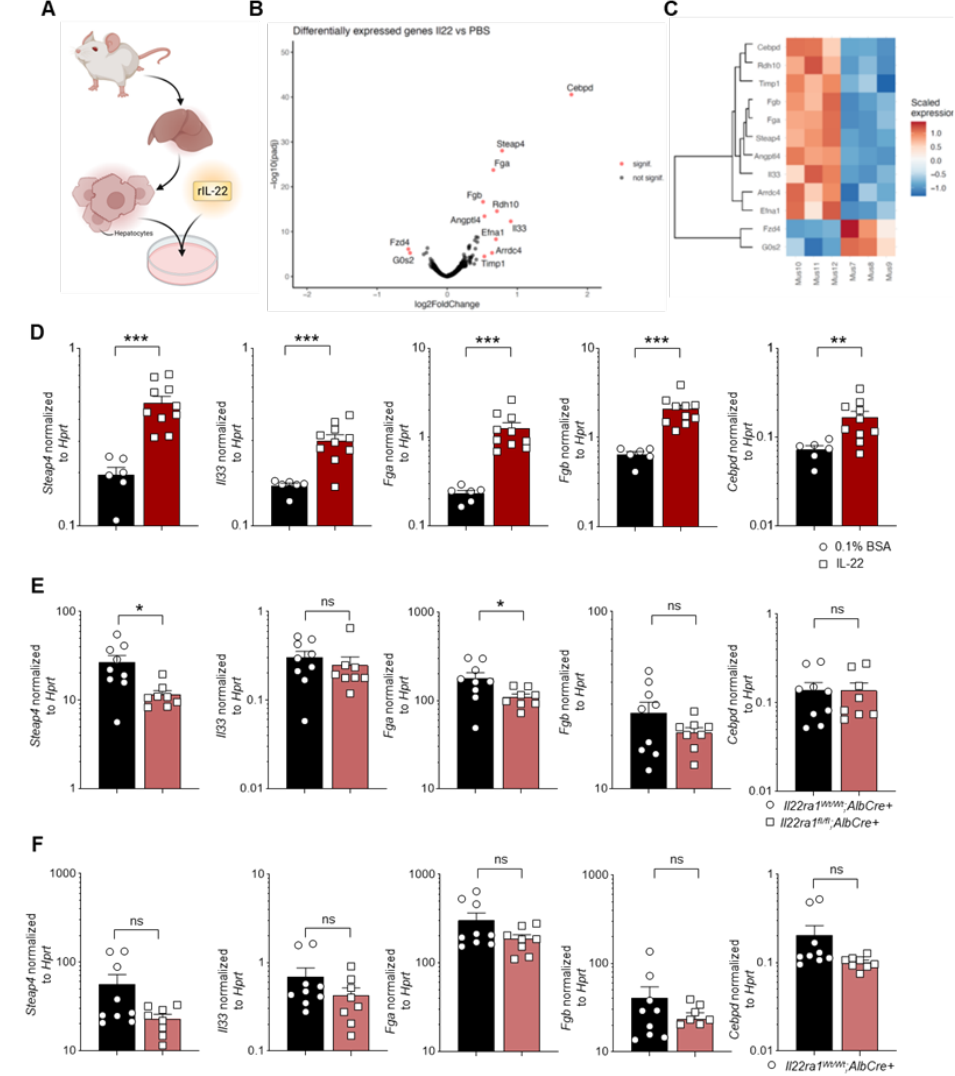
Figure 5. IL-22 signaling induces transcriptional changes in murine hepatocytes. ( A ) A schematic picture describing the experimental setup; ( B ) volcano-plot depicting the differently expressed genes in hepatocytes upon in vitro PBS-stimulation (left, n = 3) versus rIL-22 stimulation (right, n = 3); ( C ) heatmap and hierarchical clustering of differentially expressed genes in hepatocytes upon in vitro IL-22 stimulation (left, n = 3) versus PBS-stimulation (right, n = 3); ( D ) relative expression of STEAP4 , IL33 , FGA , FGB and CEBPD in comparison to HPRT in murine hepatocytes that were either stimulated with 0.1% BSA as control (black, n = 6) or rIL-22 (red, n = 10); ( E ) relative expression of STEAP4 , IL33 , FGA , FGB and CEBPD in comparison to HPRT in the livers of IL22ra1 +/+ ; Alb Cre+ (black, n = 9) or IL22ra1 flox/flox ; Alb Cre+ (red, n = 8) 6-month-old mice that underwent chemical HCC induction as outlined above; ( F ) relative expression of STEAP4 , IL33 , FGA , FGB and CEBPD in comparison to HPRT in the livers of IL22ra1 +/+ ; Cdh5 Cre+ (black, n = 9) or IL22ra1 flox/flox ; Cdh5 Cre+ (red, n = 8) mice 6 months after chemical HCC induction. Data are pooled from 2 independent experiments. Data presented as mean ± SEM. ns: p > 0.05; *: p < 0.05; **: p ≤ 0.01; ***: p ≤ 0.001 as assessed by Mann–Whitney U